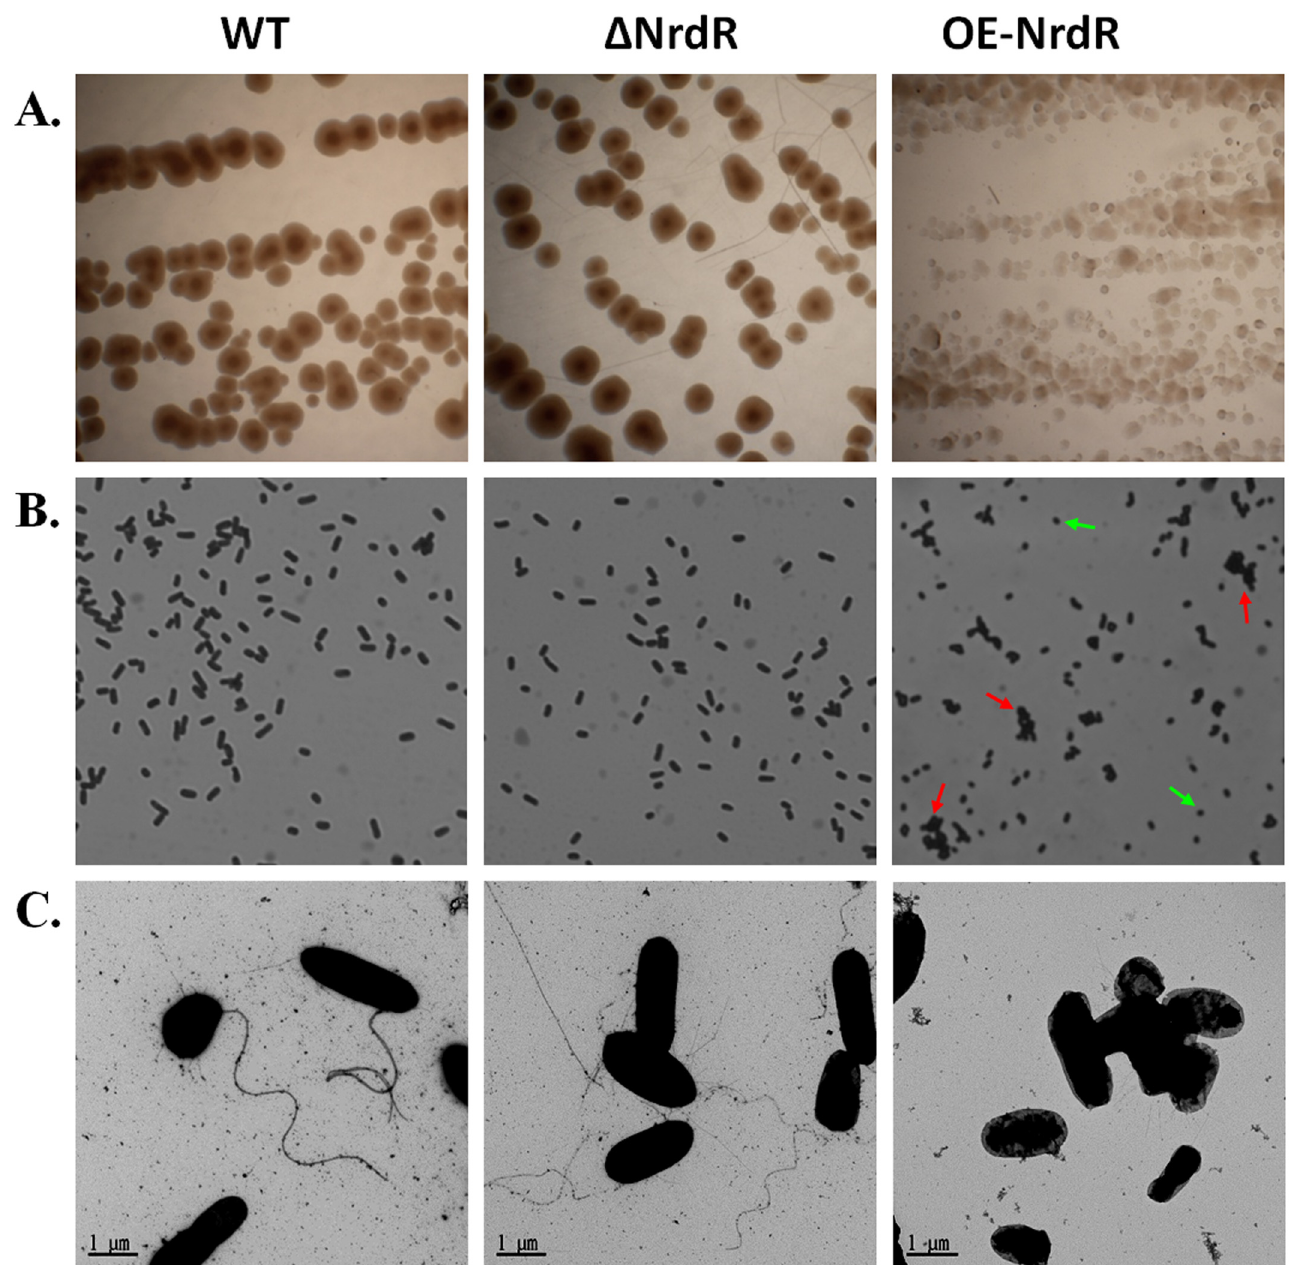
Fig 3. NrdR overexpression influences changes in bacterial morphology. (A) Colony morphology of WT, Δ NrdR and OE-NrdR E . coli strains grown on LB medium. (B) Magnification (×100) of E . coli strains. Overexpression of NrdR resulted in bacterial aggregates (red arrows) and coccobacilli (short rods; green arrows). (C) Transmission electron microscopy of the WT, Δ NrdR and OE-NrdR E . coli strains at high magnification (magnification, ×21,000). Differences in flagella and cell walls among the E . coli strains can be